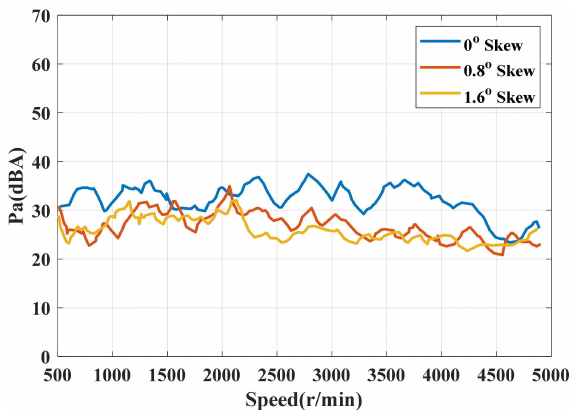
Figure 11. 48th order noise test results with different skew angles.